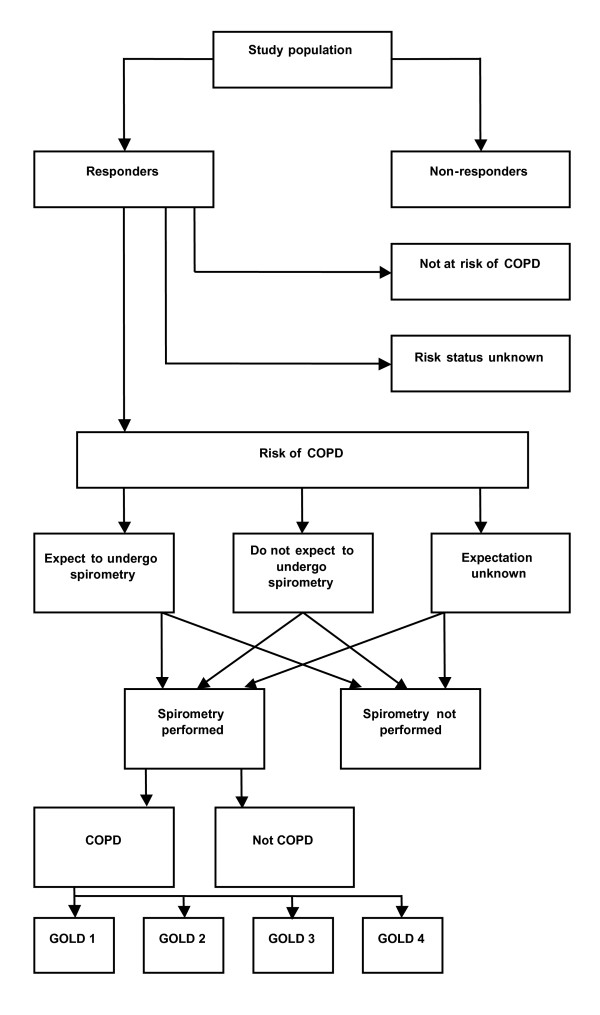
Study flow chart.